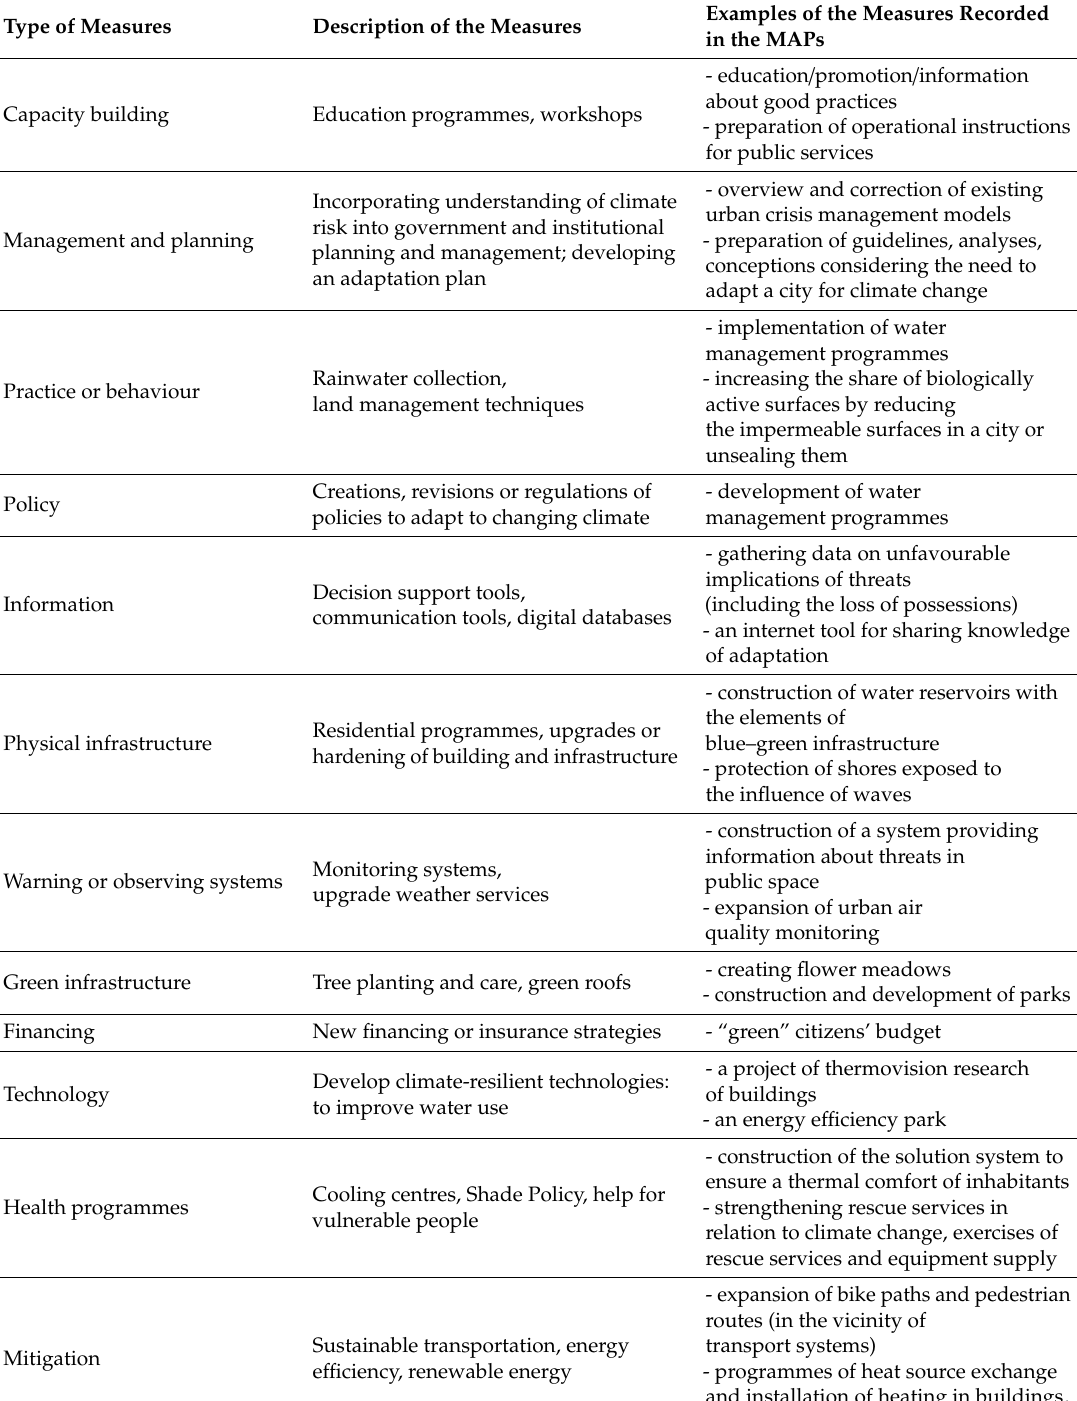
Table 2. Types of climate-oriented measures taken in